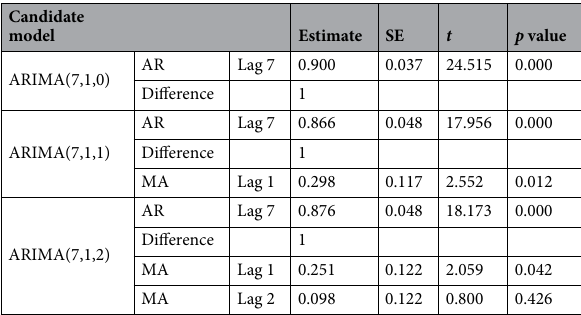
Table 3. Estimates and standard error of three candidate ARIMA models.